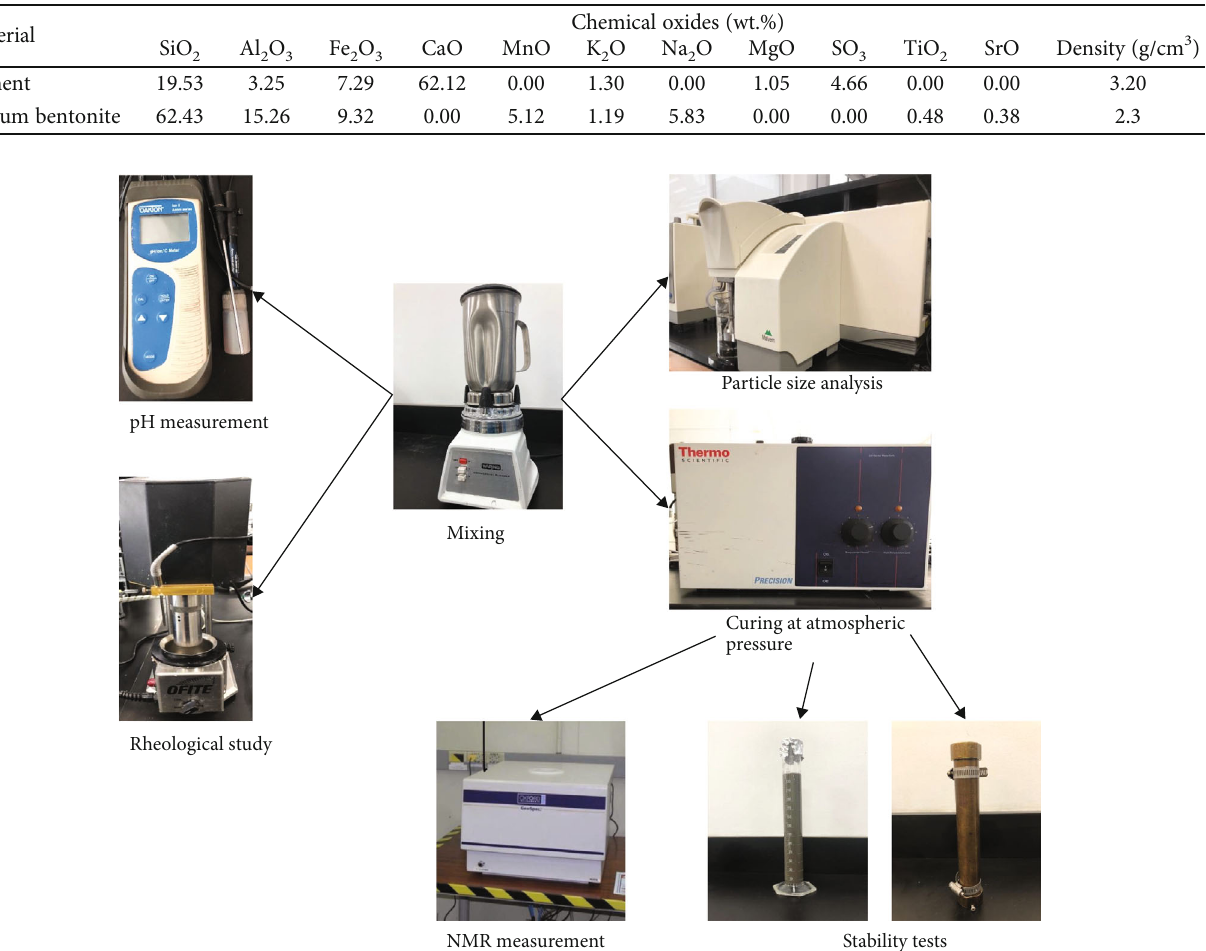
Figure 1: Flow chart of experimental work.